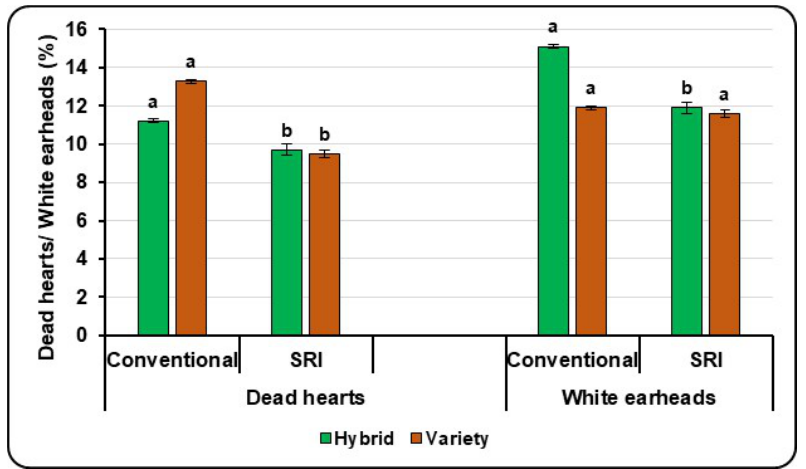
Figure 3. Stem borer incidence averaged for different cultivars. Means with the same letter are not significantly different by Tukey’s HSD ( p = 0.05) across cultivation systems for each parameter. Leaf folder incidence was observed at two locations, Pattambi and Warangal. At both of these locations, leaf folder damage was found to be higher with SRI methods compared to conventional methods. The highest incidence was observed with SRI methods at Warangal (11%), where the incidence was at par for both hybrids and varieties (Figure